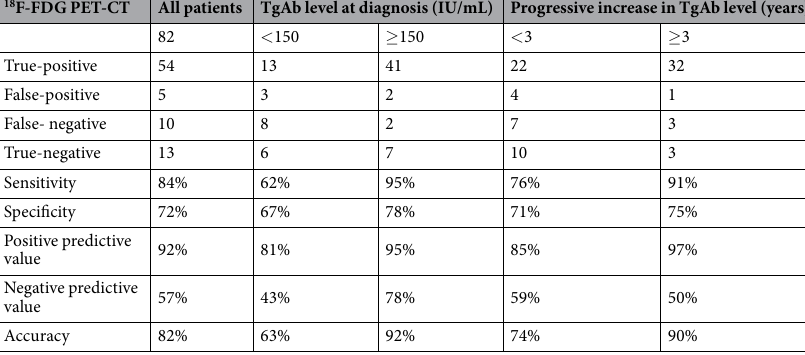
Table 5. 18 F-FDG PET-CT findings of the included patients.